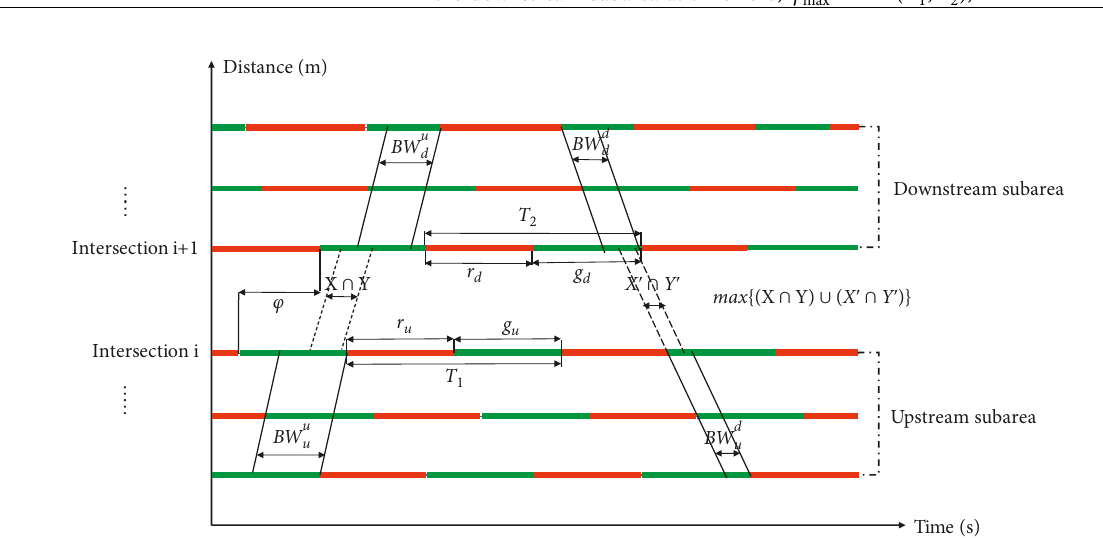
subarea; subarea;